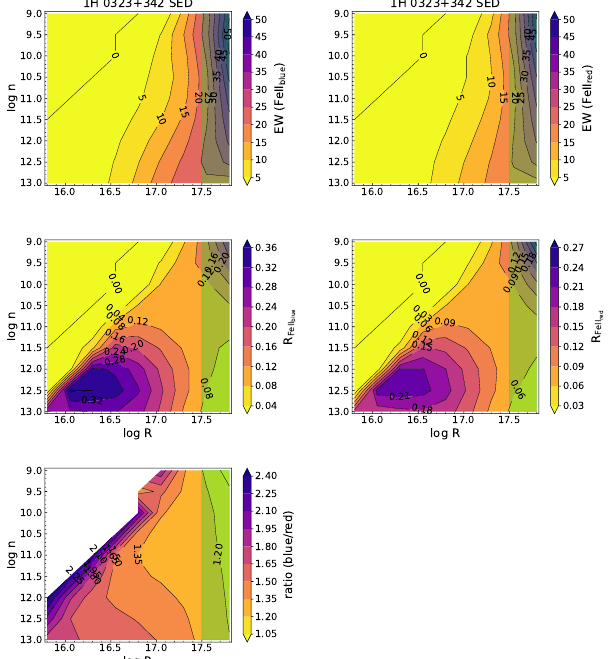
Figure A4. Results of CLOUDY simulations for the 1H0323+342 SED: the two top panel yields the equivalent width of Fe II λ 4570 and the two middle panels R FeII for the blue and red blends, as a function of density and BLR radius. The bottom panel shows the ratio of the blue and red Fe II